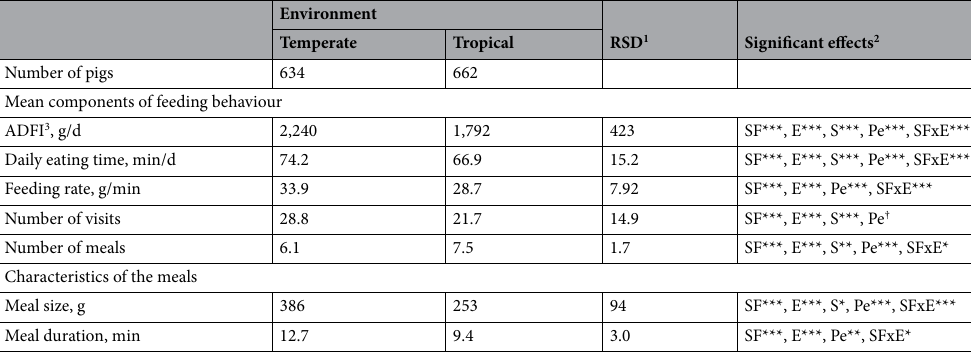
Hourly feed intake peaked twice a day as illustrated in Fig. 2a. On average, the first and the second peaks were observed between 04:00 and 10:00 and between 13:00 and 21:00, respectively. The daily kinetics of hourly feed intake was affected by environment (P < 0.001) with TROP animals having their peak of consumption earlier in the morning and with lower feed intake throughout the day. When the circadian rhythm of FI was compared with the daily kinetics of the other feeding parameters, the morning peak of FI coincided with the peak of frequency of meals and time spent eating (Fig. 2b, d), whereas the afternoon peak corresponded to the fastest feeding rate, largest meal size and a lower peak of meal frequency (Fig. 2c–f). Similar to the circadian rhythm of FI, the daily kinetics of all feeding behaviour traits was affected by environment (P < 0.001), the main difference between TROP and TEMP being a shift in the morning and afternoon peaks which occur on average 2 h earlier in TROP, except for meal duration where no peak was observed in TROP. A significant effect of sex (females vs. castrated males), was also observed for most feeding behaviour traits (P < 0.05), except for feeding rate and meal duration (P > 0.10). However, focus of the study was not put on the effects of sex, but rather on the effect of the environment and GxE interactions. In terms of differential response to the environment, we did not find significant interactions between sex and environment, suggesting that there is no difference between males and castrated females in their feeding behavior response to TROP conditions. Correlations between feeding behaviour traits. Significant residual correlations were found between feeding behaviour traits in each environment (P < 0.05, Fig. 3). Similar trends of correlations were found in each environment. In both conditions, ADFI was positively correlated with daily eating time, number of meals and meal size (r = 0.21, r = 0.21, r = 0.54 respectively in TEMP and r = 0.42, r = 0.23, r = 0.39 respectively in TROP, P < 0.001). Number of meals was negatively correlated with meal size and duration (r = − 0.64, r = − 0.57, respec- tively in TEMP and r = − 0.73, r = − 0.66, respectively in TROP, P < 0.001), and positively correlated with daily eating time (r = 0.32 in TEMP and r = 0.40 in TROP, P < 0.001). Feeding rate was positively correlated with meal size (r = 0.58 in TEMP and r = 0.42 in TROP; P < 0.001), and negatively correlated with daily eating time and meal duration (r = − 0.46, r = − 0.33, respectively in TEMP and r = − 0.44, r = − 0.22, respectively in TROP; P < 0.001). Few traits vary importantly in their correlation coefficient between TEMP and TROP conditions. Residual cor- relation between feeding rate and ADFI was higher in TEMP than TROP (r = 0.71 vs. 0.51, P < 0.001). There was a higher residual correlation between meal size and meal duration in TROP than in TEMP (r = 0.72 vs. r = 0.50, P < 0.001 respectively). Phenotypic correlation between behaviour traits and production traits. Similarly to residual correlations between feeding behaviour traits, similar trends in both environments were found for residual cor- relations between feeding behaviour and production traits (Fig. 3). In both environments, feed efficiency meas- ures (FCR and RFI) were highly correlated to ADFI (r = 0.90, r = 0.91 in TEMP and r = 0.72, r = 0.73 in TROP, P < 0.001). Nevertheless, strong differences in the size of correlations were found between environments. In par- ticular, residual correlation between feeding rate and ADG were higher in TROP than in TEMP (r = 0.46 vs. 0.19, P < 0.001). FCR and RFI showed high correlation with daily eating time in TROP (r = 0.45, r = 0.48 respectively, P < 0.001) whereas in TEMP, FCR and RFI were more strongly correlated with feeding rate (r = 0.67, r = 0.70 respectively, P < 0.001) and meal size (r = 0.47, r = 0.47 respectively, P < 0.001). Phenotypic correlation between behaviour traits and thermoregulation traits. In both envi- ronments, thermoregulation traits were poorly correlated with feeding behaviour traits and these correla- tions were rarely significant (P > 0.05, Fig. 3). ST showed a small positive correlation with ADFI in TEMP only (r = 0.10, P < 0.01). Mean rectal temperature between 19 and 23 weeks (RT 19-23 ) was positively correlated with